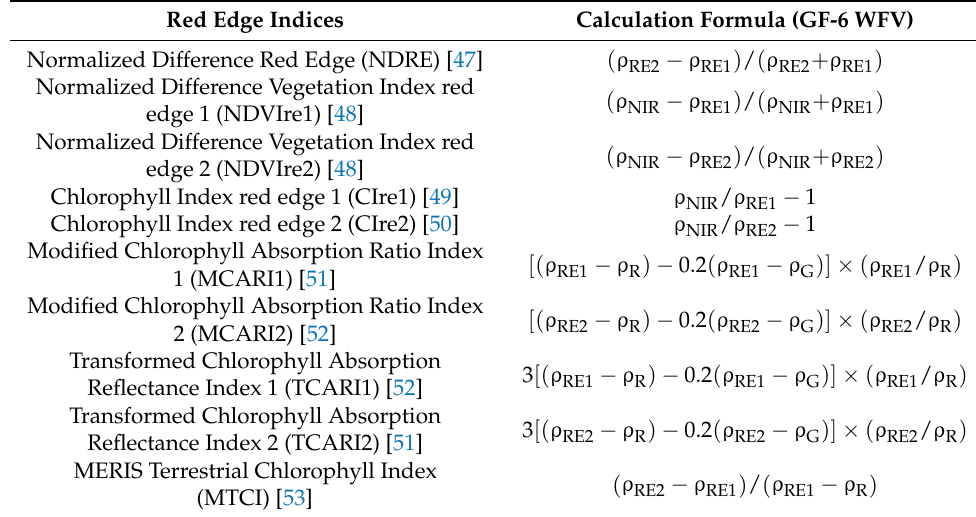
Table 3. Red edge vegetation index based on GF-6 WFV data (10 kinds). Red Edge